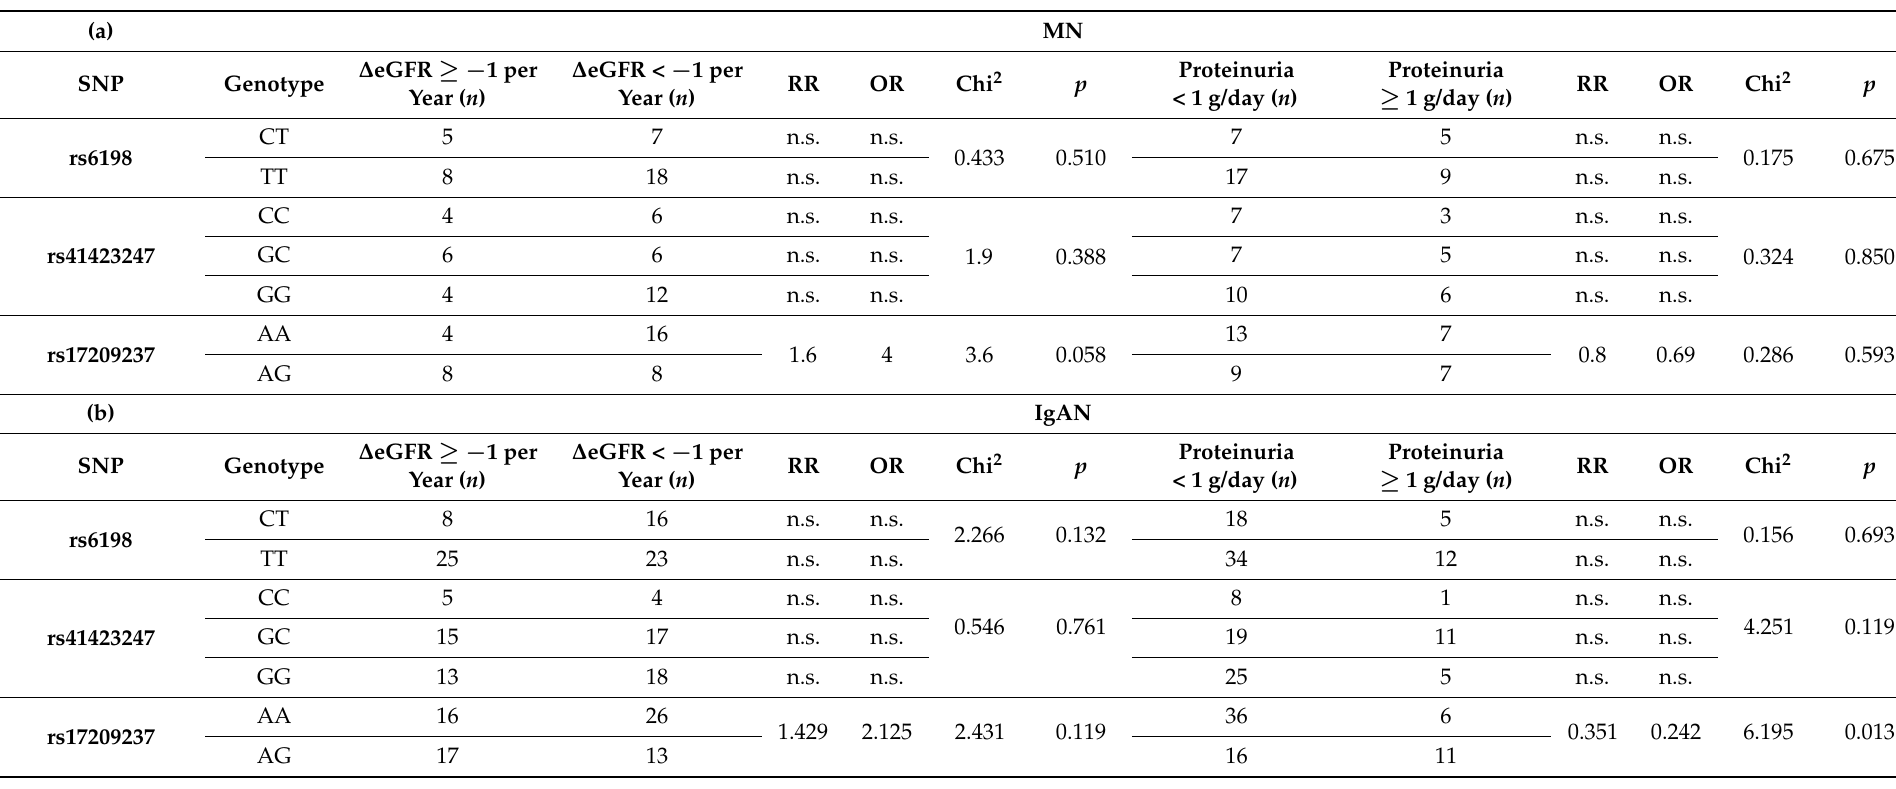
Table 5. The correlation between rs6198, rs41423247 or rs17209237 NR3C1 polymorphisms with ∆ eGFR/year or proteinuria (g/day) after 1-year follow-up time for ( a ) MN; ( b ) IgAN; ( c ) all patients. Number of patients ( n